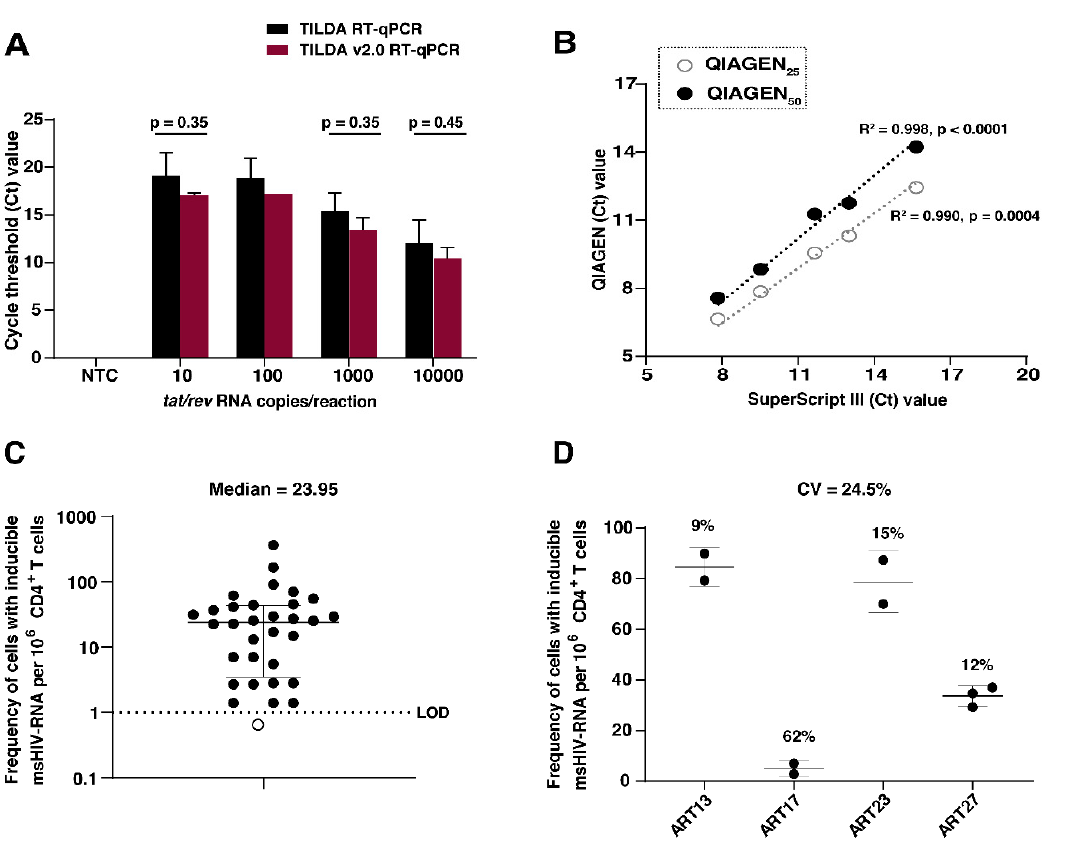
Figure 1. TILDA analytical and clinical sensitivity. ( A ) Detection of serial dilutions of a synthetic tat/rev RNA template in the absence of cells using the original TILDA RT-qPCR conditions compared to the TILDA v2.0 RT-qPCR conditions. Three wells per dilution were tested based on cycle threshold (Ct) values. NTC = Negative template control. A multiple paired t -test was used to compare mean Ct values. The error bars represent the SD of the mean of two independent runs. ( B ) Dilutions of 10–10,000 copies of tat/rev RNA were pre-amplified using different reaction volumes using QIAGEN (25 µL; open circles, and 50 µL; closed circles) or Superscript III Platinum one-step RT kits. Three wells per dilution were tested for positivity. A Pearson’s correlation test between the reference and two test kits is shown. Statistical significance is determined by p < 0.05. ( C ) Quantification of inducible HIV-1 reservoirs in clinical samples. Frequency of CD4+ T cells expressing tat/rev msRNA after in vitro stimulation with PMA/Ionomycin ( N = 32 HIV-1-infected individuals on suppressive cART). Target was not detected for one sample, indicated using an open circle. The median and interquartile range is shown (the median frequency of cells with inducible tat/rev msRNA per million CD4+ T cells = 23.95). The dotted line represents the assay limit of detection (LOD). ( D ) The inter-assay coefficient of variation (CV) determined from TILDA measurements of four individuals. Mean CV= 24.5%. The other numbers represent the CV for each individual calculated from a minimum of two independent measurements. The error bars represent SD of the